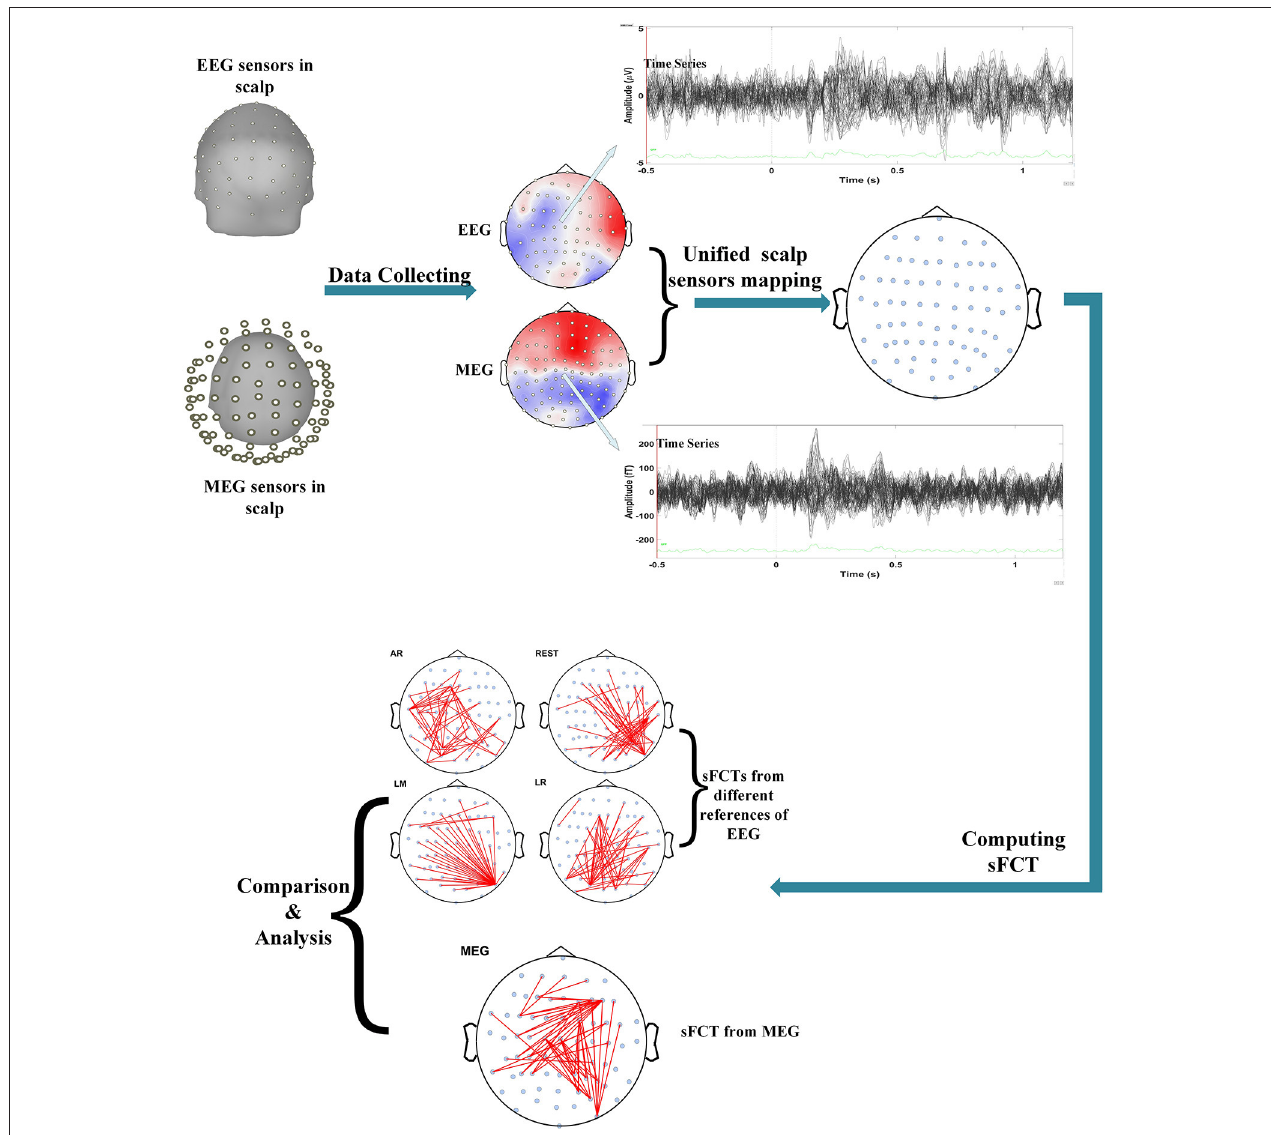
FIGURE 1 | Flowchart depicting the procedure for real data. Processing included several important steps. First, data is set so that scalp MEG collection and scalp EEG collection come from the same stimulus. Second, electrode transformations are conducted by unifying the EEG and MEG sensors on the scalp. Then, sFCTs are computed for each EEG reference scheme and for MEG. Finally, the differences between methods are analyzed with quantized metrics.